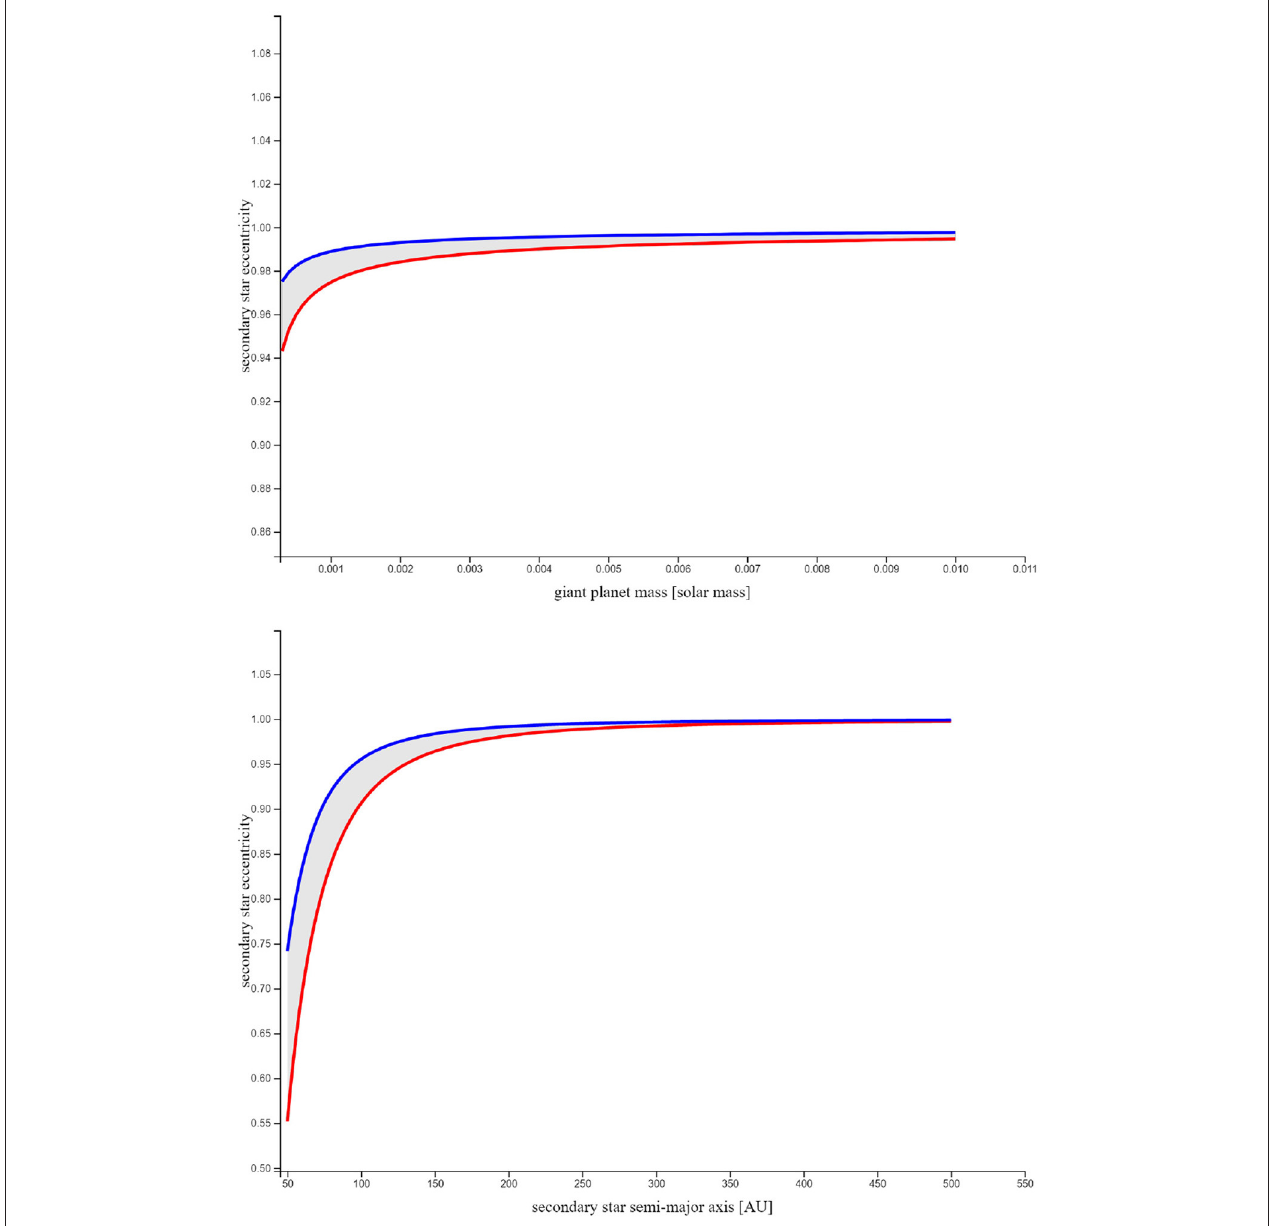
FIGURE 6 | Same as Figure 3 but for the variation of the giant planet’s mass (x-axis) vs. a variation of the binary’s eccentricity on the y-axis (Upper) . The (Lower) shows a variation of the secondary star’s semi-major axis (x-axis) vs. the binary’s eccentricity